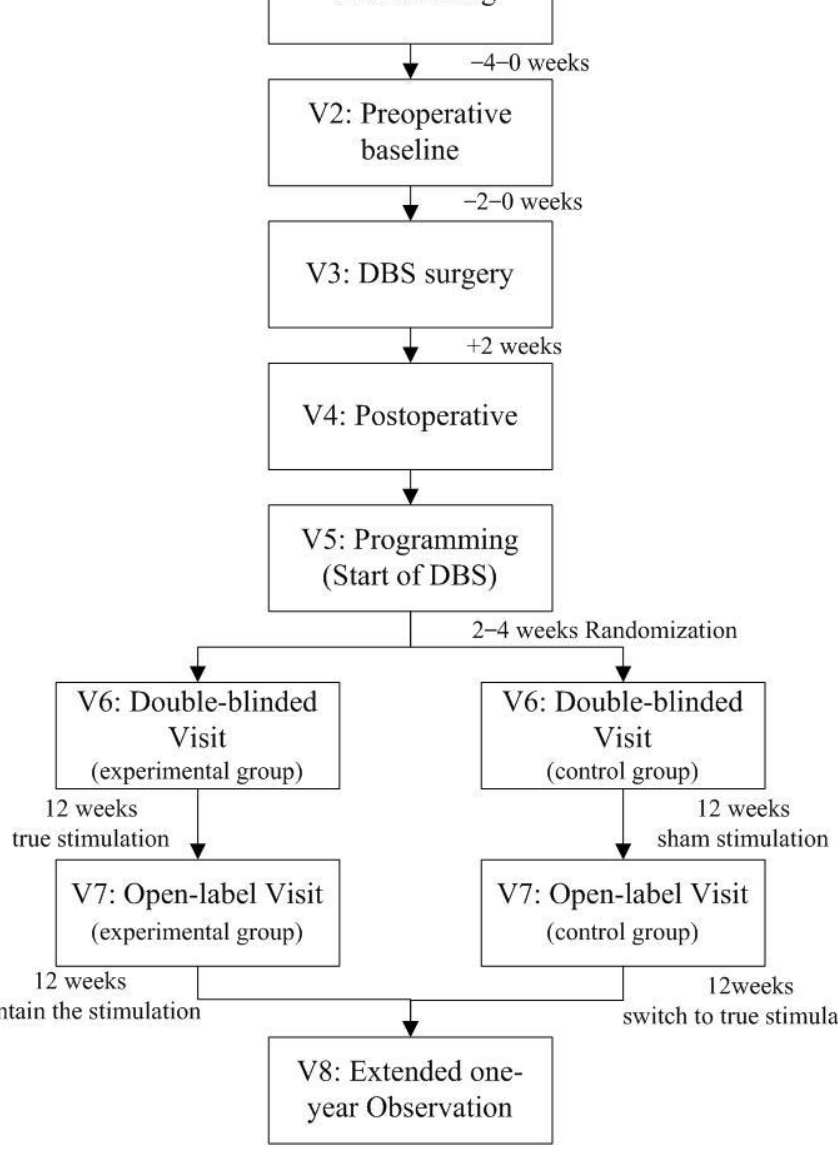
Figure 1. Flow chart of the study.